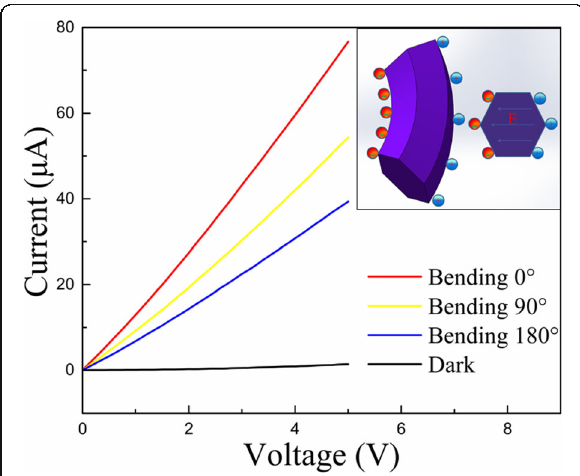
Fig. 4 I – V characteristic in dark and under UV illumination at different bending angles. The inset (left) shows the bending strain-induced nonmobile ionic charges at the outer (positive) and inner (negative) surfaces of the ZnO MW, and the inset (right) shows the piezo-induced electric field and piezopotential distribution at the cross-section of the bent ZnO